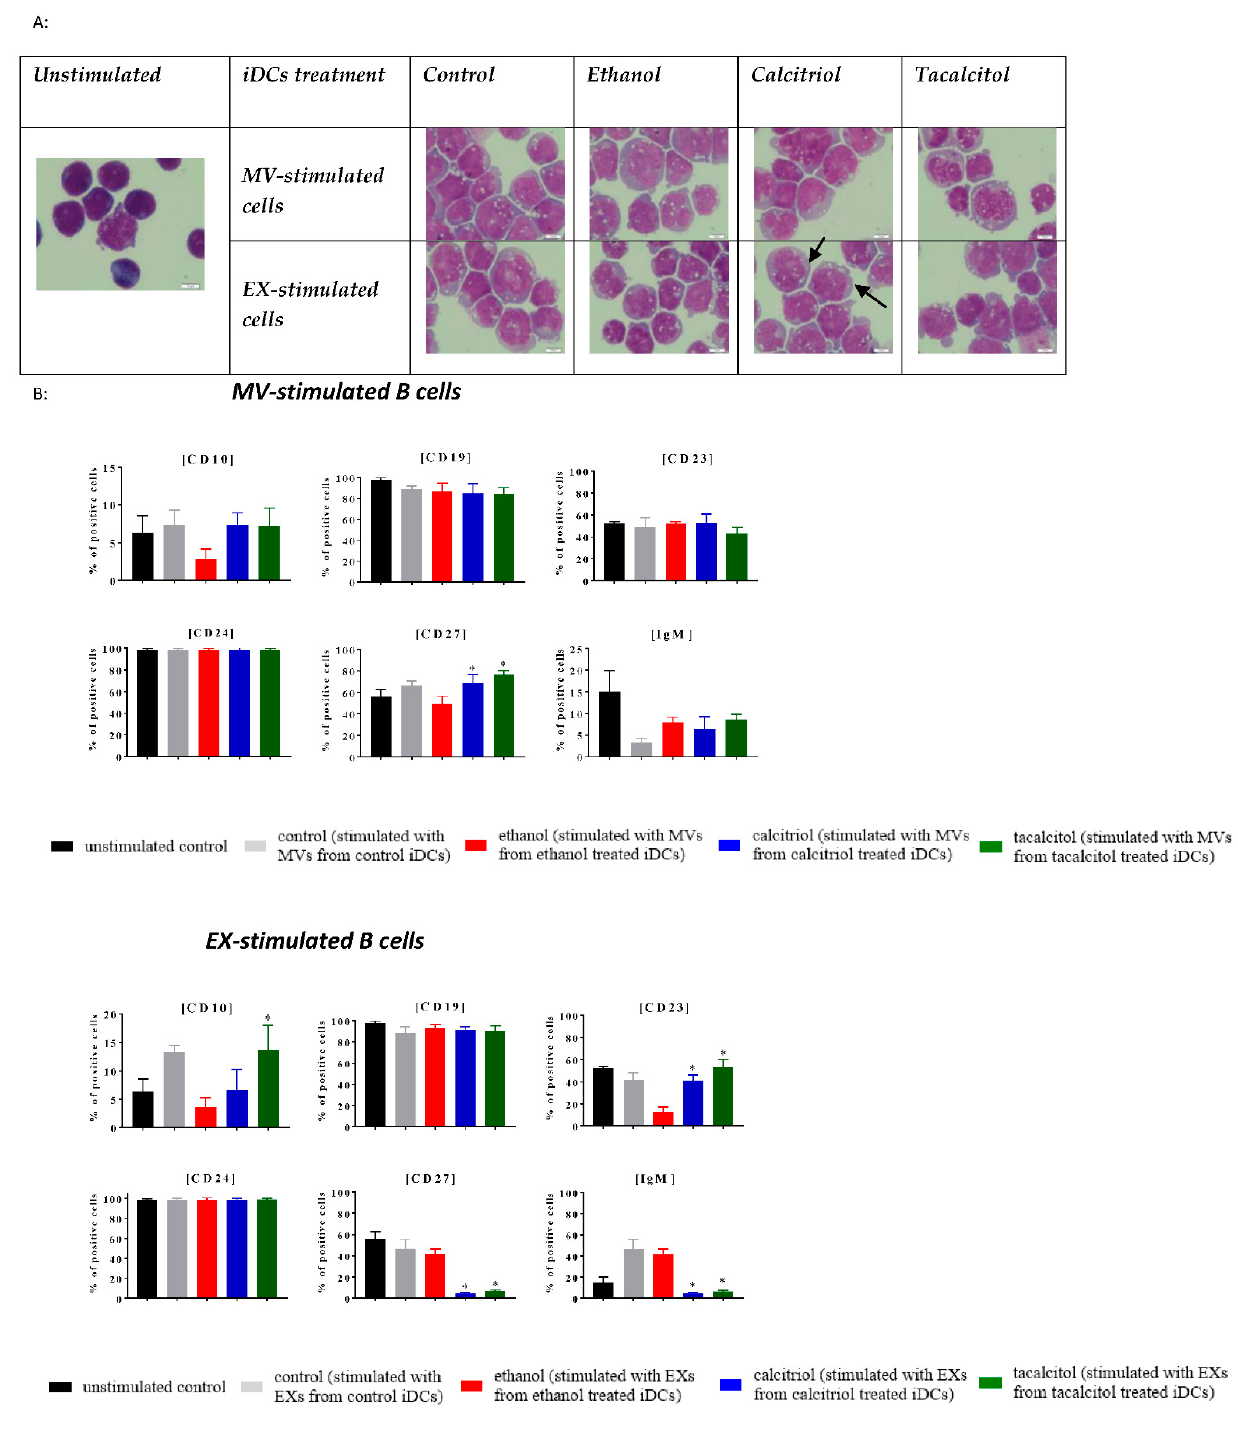
Figure 12. The indirect effects of calcitriol and tacalcitol on KOPN-8 cell line after 24 h stimulation with EVs derived from iDCs: ( A ) morphology of EV-stimulated KOPN-8 cells; scale bar 10 μ m. Each staining was performed twice; Black arrows indicate vacuolization in cells. ( B ) distribution of differentiation markers by flow cytometry analysis. Mean values and standard deviation are presented. Statistical analysis: Sidak’s multiple comparison tests in comparison with ethanol were performed; significant differences as compared with ethanol (* p < 0.005). Each experiment was performed at least 3 times.